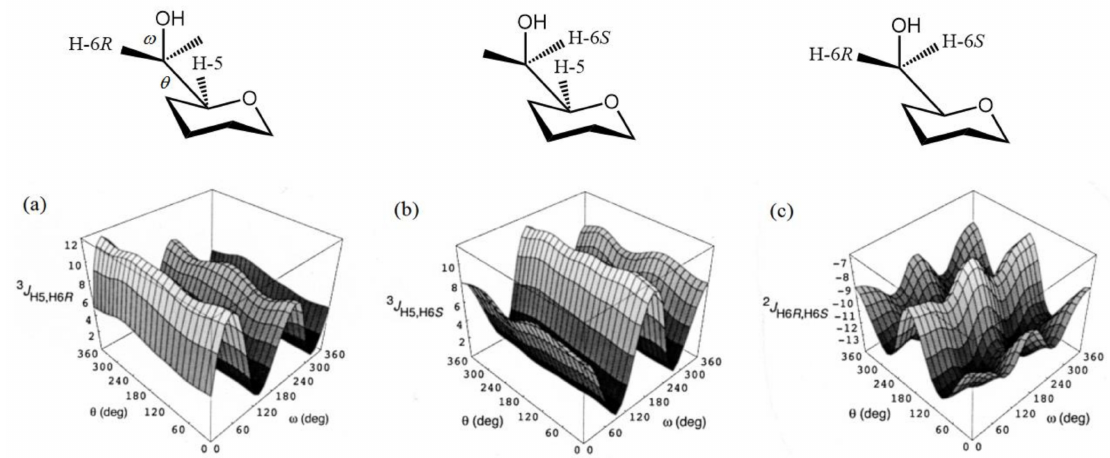
Figure 22. Hypersurfaces of ω and θ dihedral angles calculated for ( a )— 3 J H5,H6 R , ( b )— 3 J H5,H6 S , and ( c )— 2 J H6 R ,H6 S in the re- stricted compound modelling hexopyranoside cycle. Reproduced with minor editing privilege from Thibaudeau et al. [127] with the permission of the American Chemical